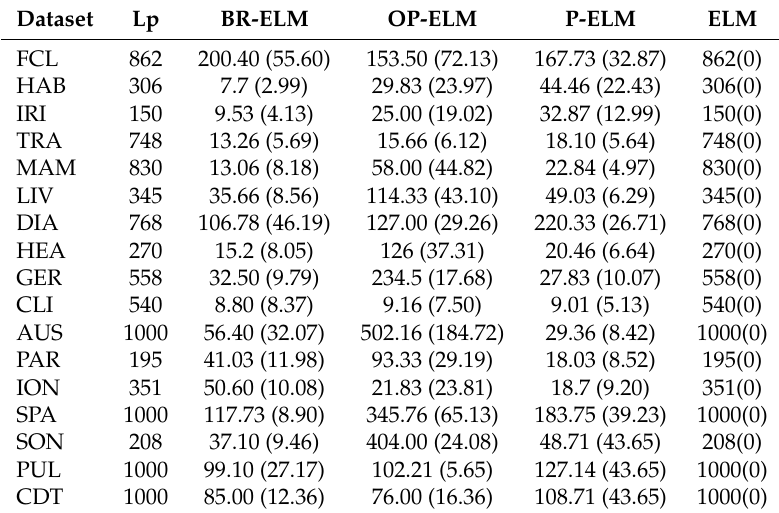
Table 6. Number of neurons selected in the